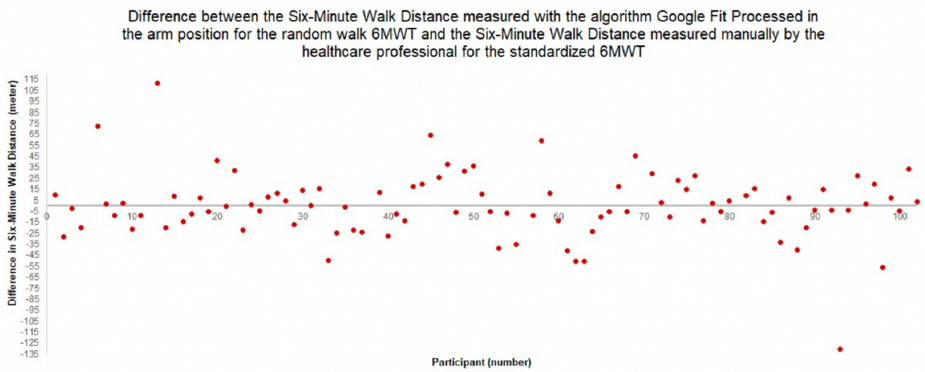
Figure 5. Bland–Altman plot of the difference between the six-minute walk distance for the random walk 6MWT as measured by the algorithm Google Fit Processed in the arm position and for the standardized 6MWT as measured manually by the healthcare professional.